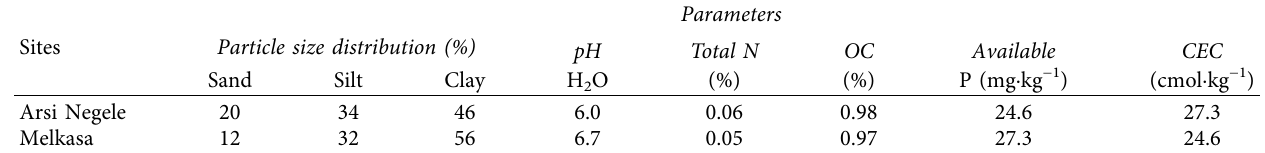
Table 2: Soil physicochemical properties of the experimental